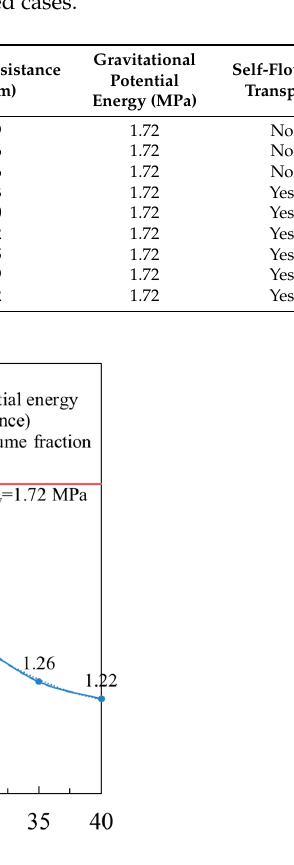
Figure 9. Total pressure profiles for various bubble volume fractions. Table 4. The resistances in the various studied cases.